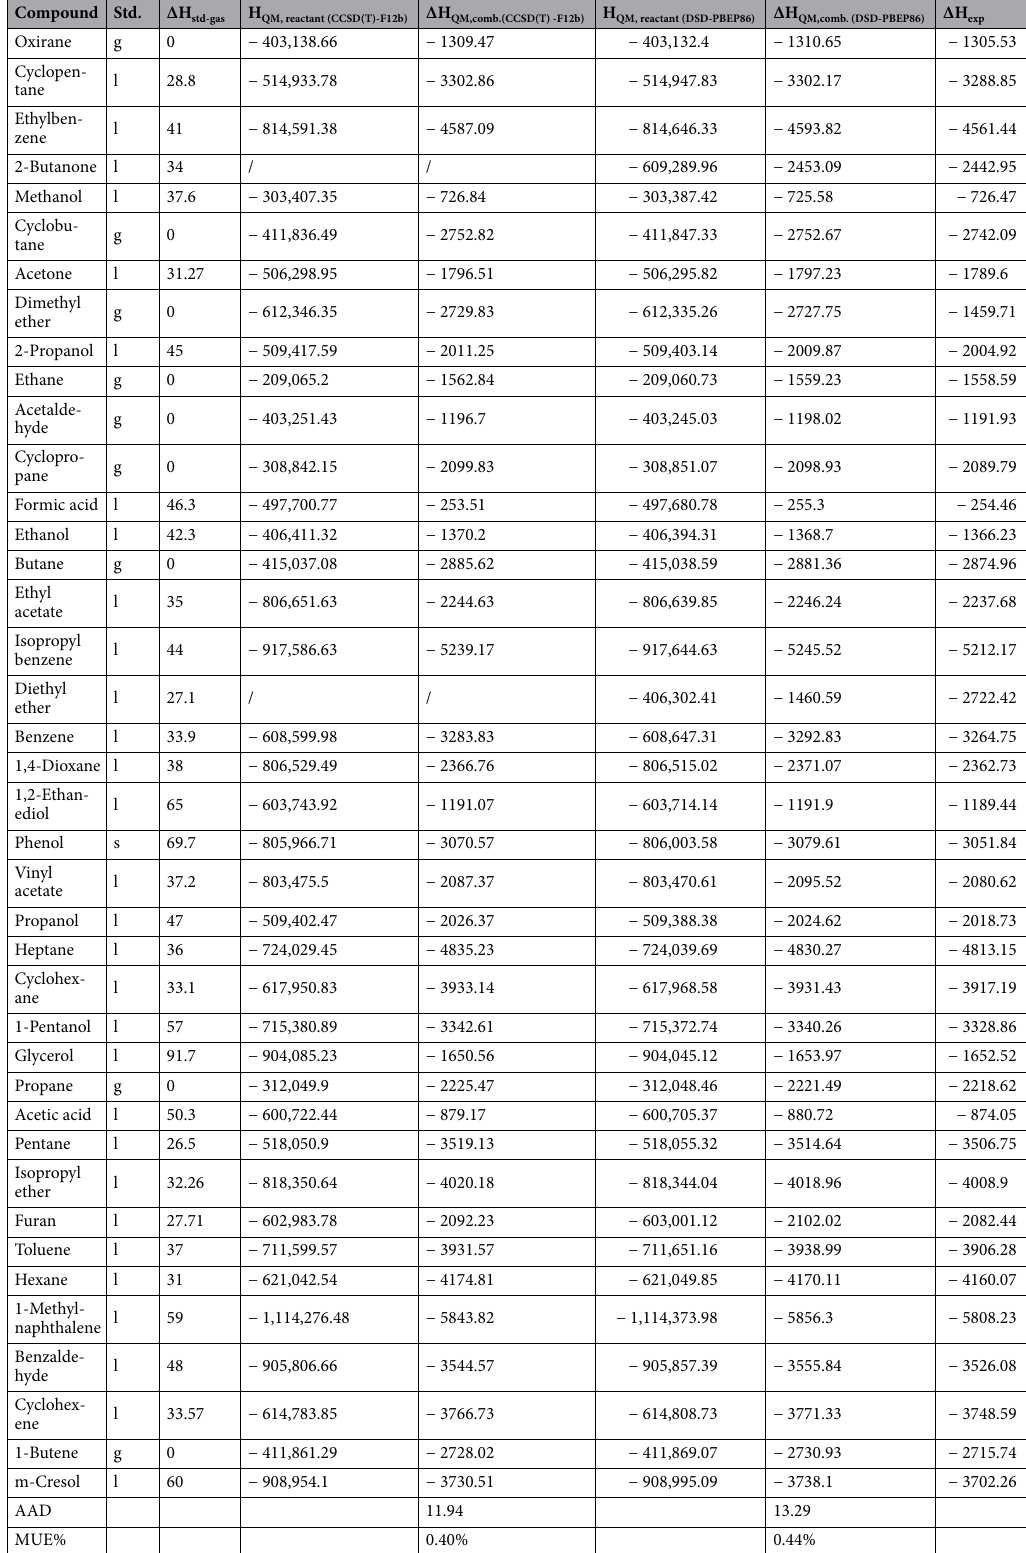
Table 1. Details of the theoretical and experimental data. All enthalpies are in kJ/mol. The columns from left to right represent: Std. standard state (gas = g, liquid = l, solid = s), ΔH std-gas the enthalpy of phase change from the standard state to the gas phase, H QM,reactant the QM enthalpies of individual reactants in the gas phase, ΔH QM,comb . the combustion enthalpy directly obtained via QM enthalpy of reaction, ΔH exp the experimentally determined